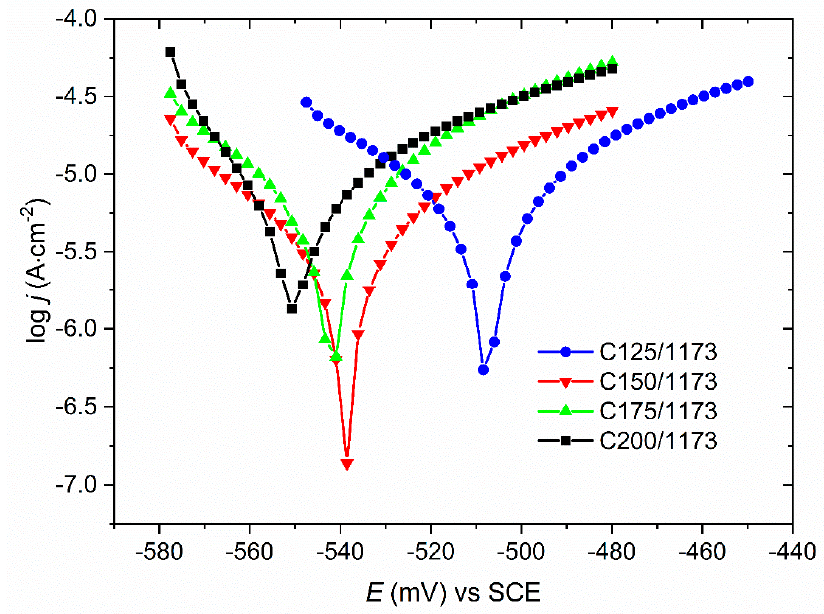
Figure 3. Potentiodynamic curves registered in 5 wt.% NaCl solution for the Ni-W coatings after heat treatment in the air, in dependence on deposition current density. Table 2. Corrosion potential E corr and corrosion current density j corr determined for Ni-W coatings